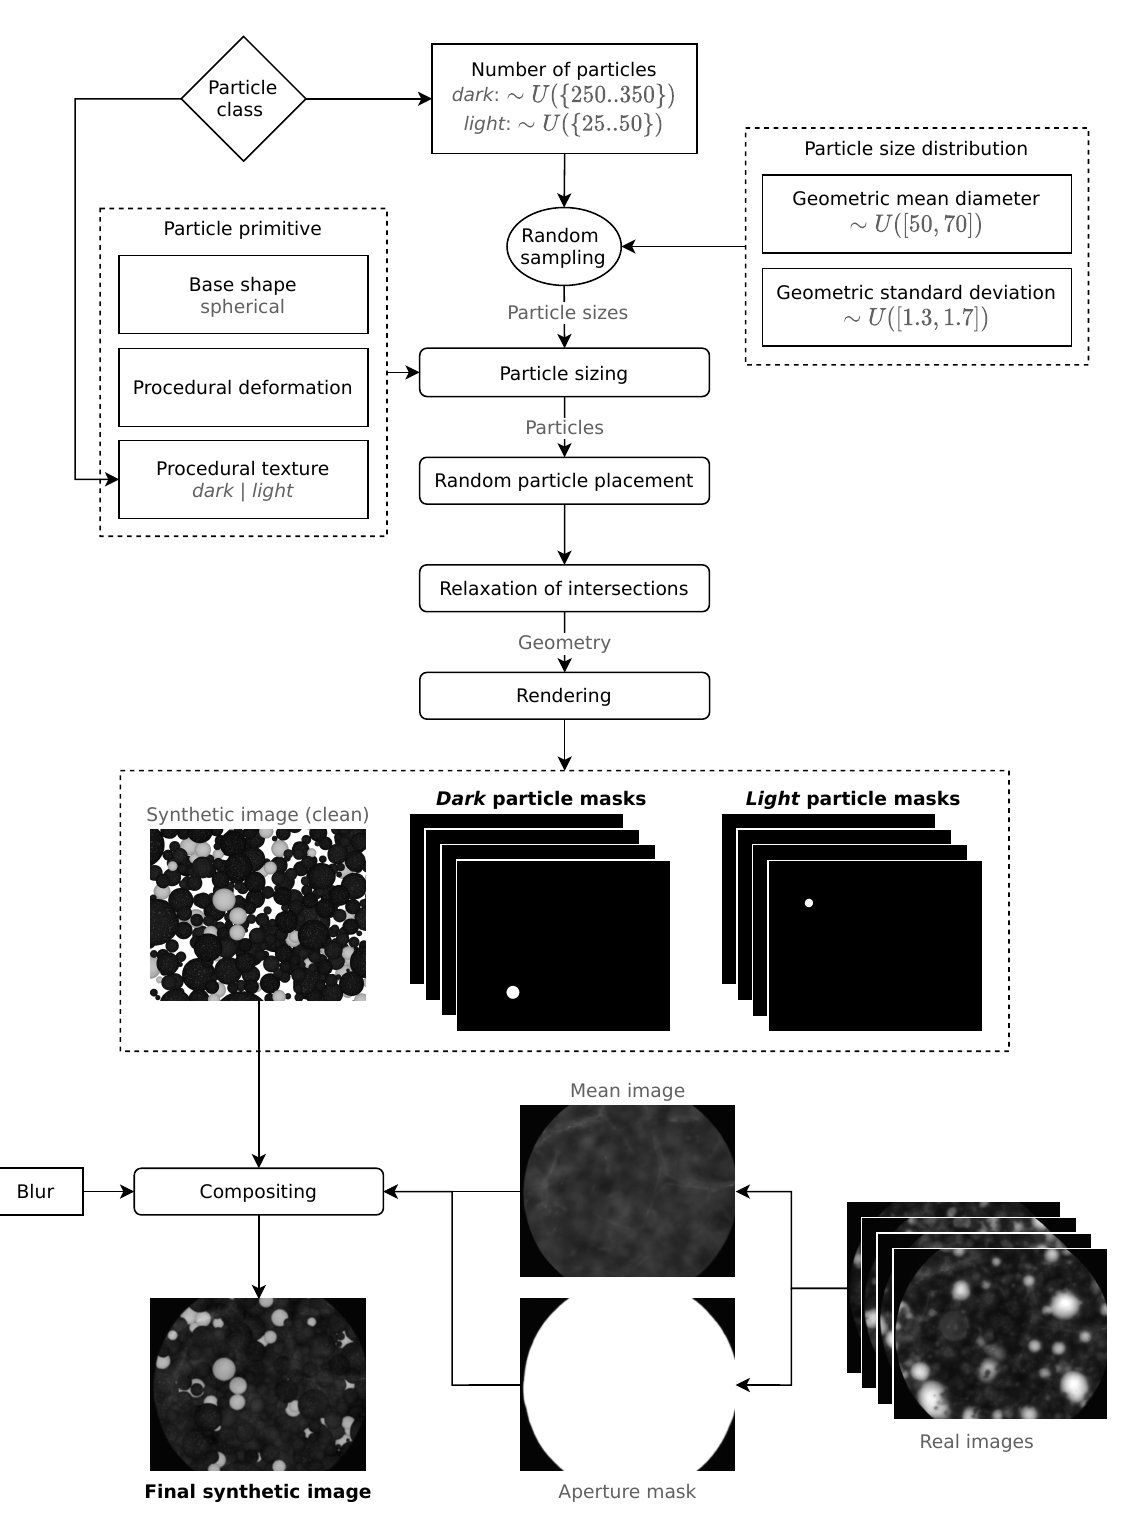
Figure 6. Illustration of image synthesis procedure for a single image. U is a uniform